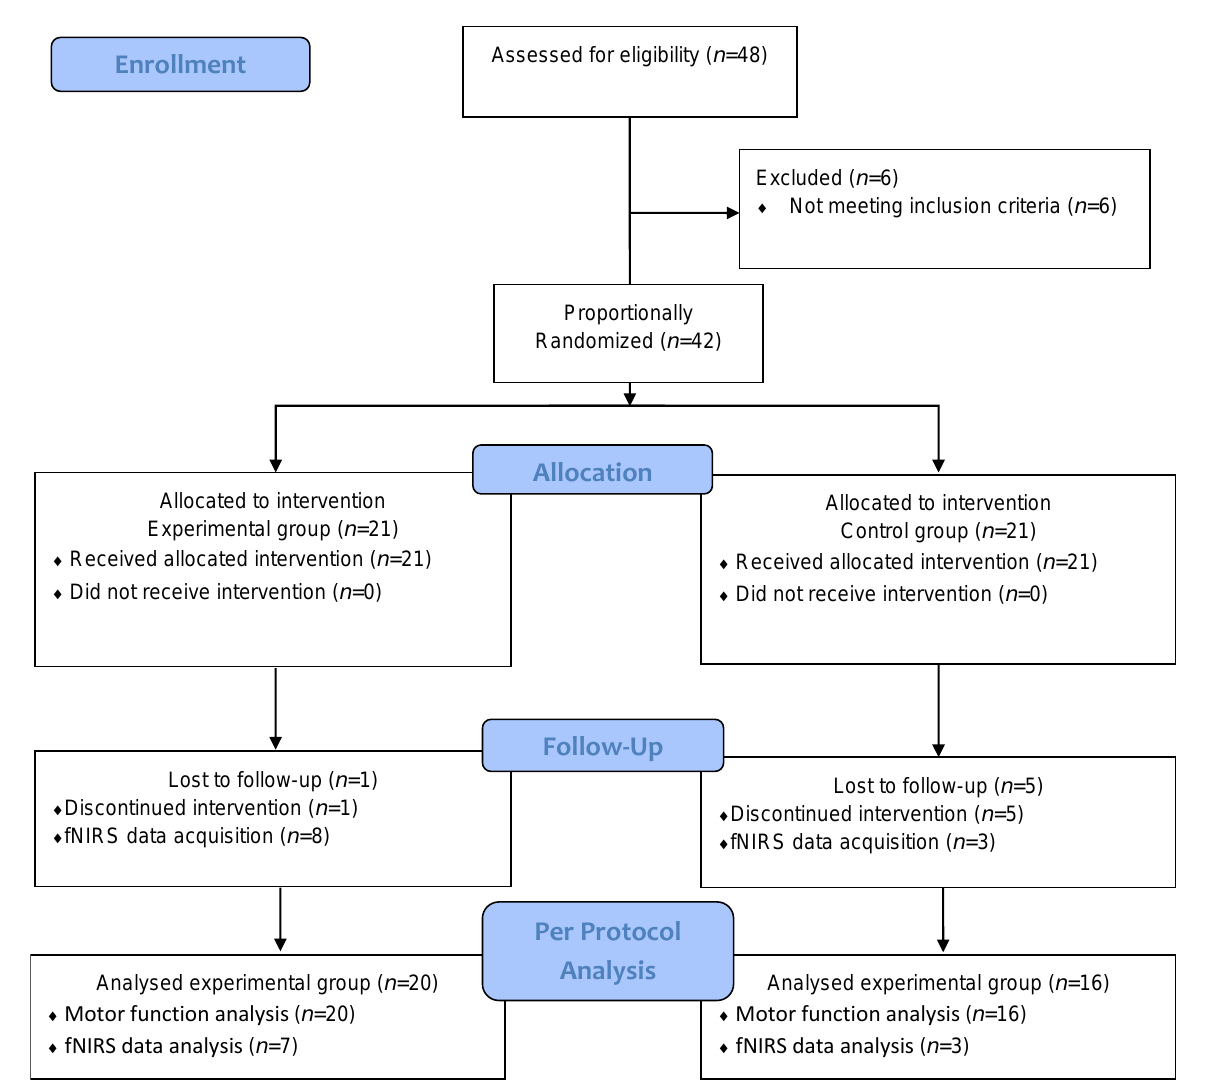
Figure 1. Consort flow diagram. fNIRS: functional near-infrared spectroscopy. Table 1. Baseline characteristics of the study population.